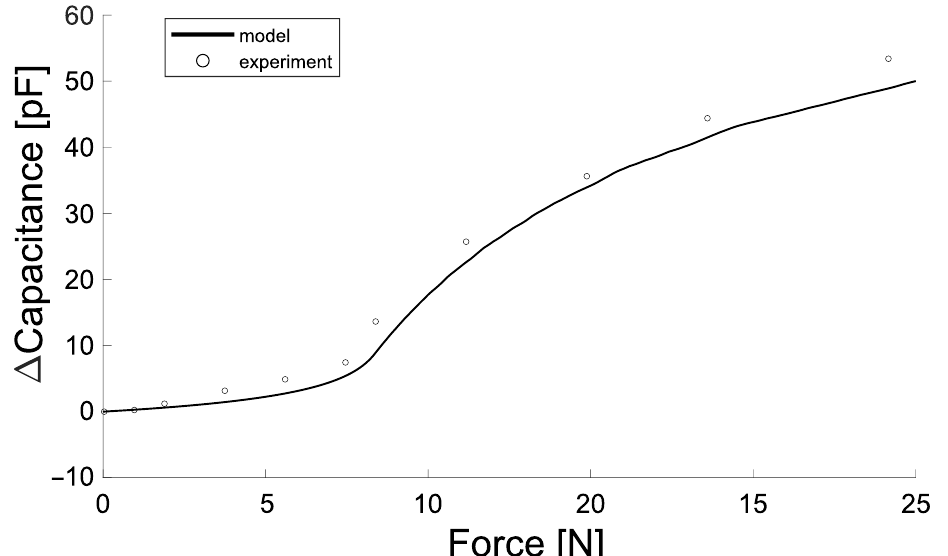
Figure 4. The dimensions of the sensor are determined based on a theoretical model of the sensor. The region of interest for the application is to measure the forces ranging from 0 to 25 N. In this range the model is able to accurately predict the response of the sensor. The capacitance response of the sensor is based on the deflection of the plates which is modelled using a finite element analysis. In Section 2.5, the methods on how these data are obtained are detailed.